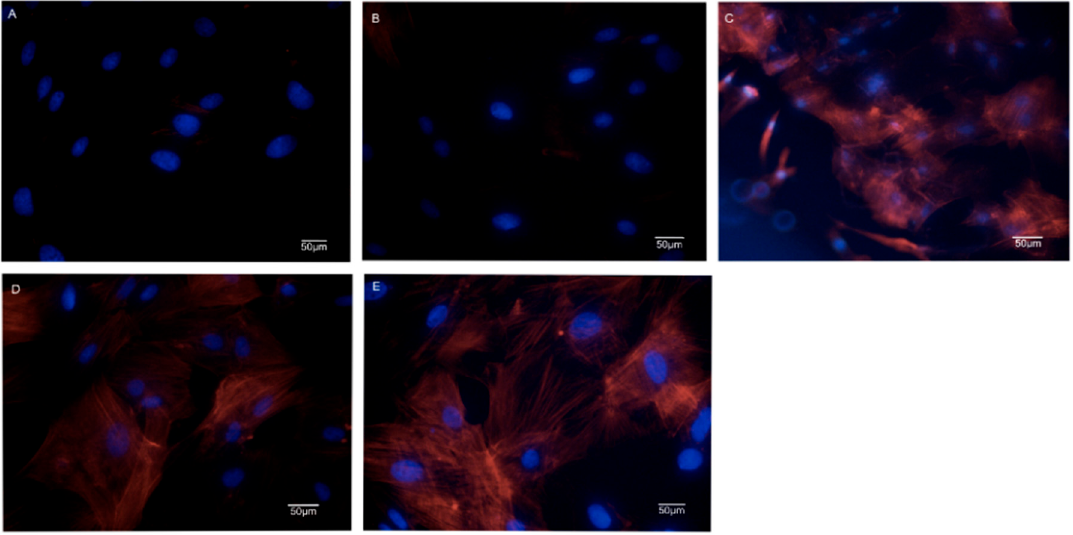
Figure 11. Confocal images of BMSCs on the SF/SPI-based scaffolds (( A ): SF; ( B ): SF/SPI; ( C ): SF/SPI/GO; ( D ): SF/SPI/ β -TCP; ( E ): SF/SPI/GO/ β -TCP).